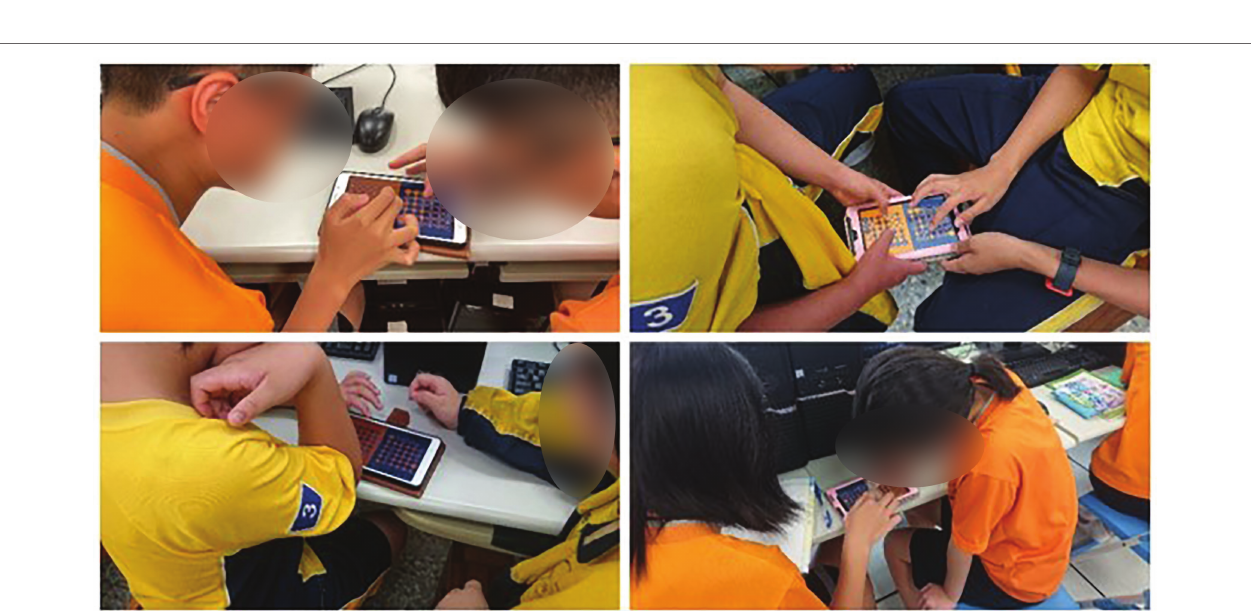
FIGURE 6 | Learning activities for EG2.